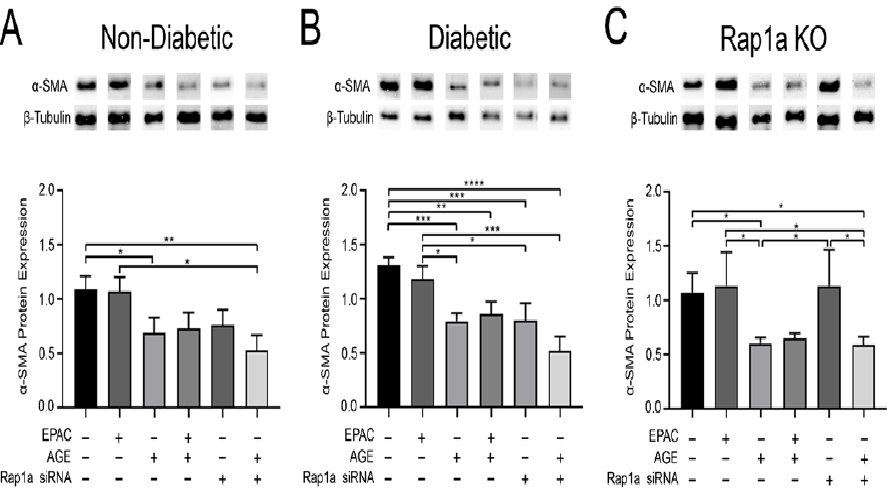
Figure 3. Increased AGE/RAGE signaling and reduced Rap1a expression induced a decrease in α- SMA expression. Cardiac fibroblasts were isolated from ( A ) non-diabetic, ( B ) diabetic, and ( C ) Rap1a KO mice hearts. Fibroblasts were either untreated, treated with a single pharmacological modifier, or treated in combination with EPAC (100 µ M), EPAC + AGE (100 µ M and 0.5 mg/mL, respectively), Rap1a siRNA (100 nM), or Rap1a siRNA + AGE (100 nM and 0.5 mg/mL, respectively). α -SMA (42 kDa) expression was assessed in cardiac fibroblasts. Expression of α -SMA was normalized to β -tubulin (55 kDa) and mean ± SEM are depicted on graphs (n = 5–11). Data depicted for exogenous AGE treatment group for non-diabetic and diabetic fibroblasts were previously presented Figure 1. Representative western blot images are shown above graphs but are not displayed as a continuous blot due to running order on the blot not aligning with graphical order of samples. However, original western blot images are available at DOI:10.6084/m9.figshare.12625409. Statistical analysis consisted of a one-way ANOVA followed by a Fisher’s protected least significant difference post hoc (* p < 0.5, ** p < 0.01, *** p < 0.001, **** p <